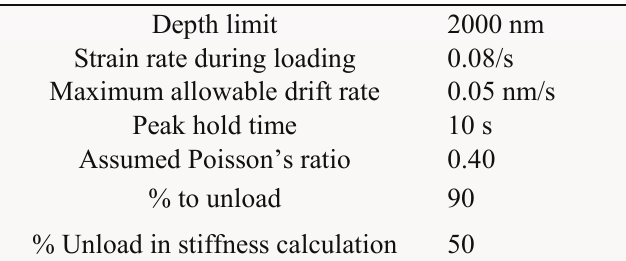
Table 2. Parameters used for quasi-static indentation measurements